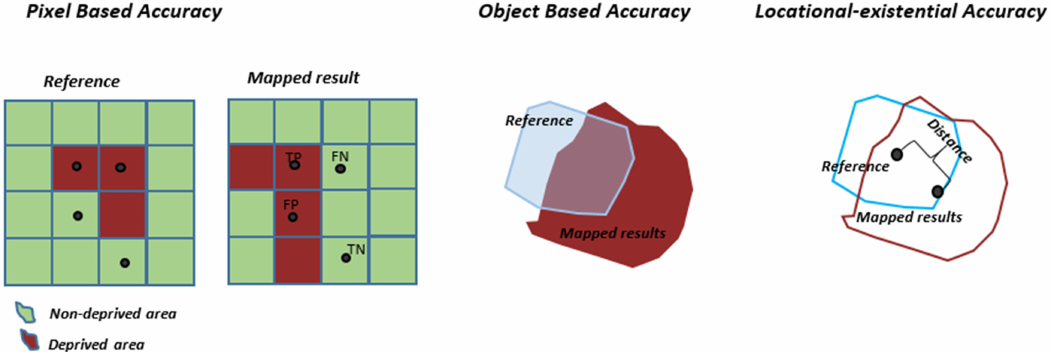
Figure 9. Main groups of accuracy assessment methods, which are relevant to assess mapping results of deprived